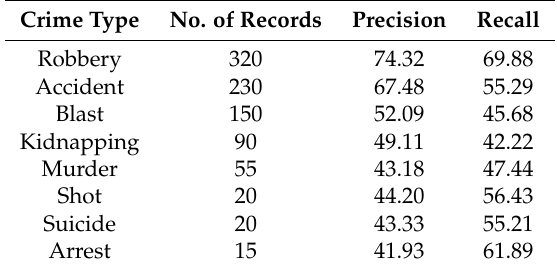
Table 2. Number of records of each crime category and their evaluation